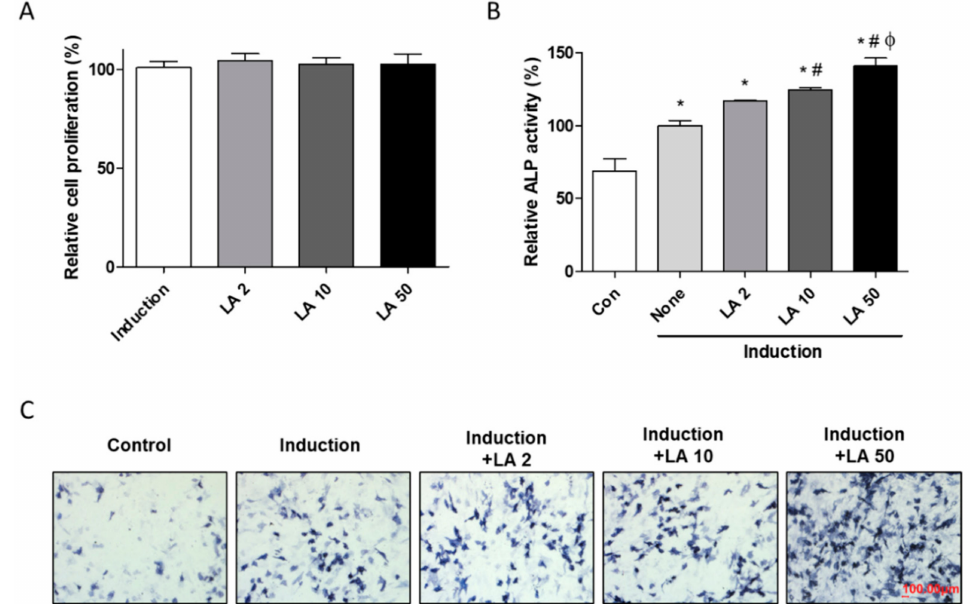
Figure 4. Effect of loganic acid on osteoblast differentiation in preosteoblastic MC3T3-E1 cells. Cells were incubated with osteoblast induction media (50 µ g/mL of ascorbic acid and 10 mM of β -glycerophosphate) and co-cultured with loganic acid (2, 10, and 50 µ M) for 3 days. Osteoblastic differentiation was assessed by ( A ) cell proliferation, ALP activity ( B ), and ALP staining ( C ). LA: loganic acid, Control: non-osteoblast induction media-treated group, None (Induction): osteoblast induction media-treated group. * p < 0.05 vs. Con, # p < 0.05 vs. None (Induction), φ p < 0.05 vs. LA2 (ANOVA with Tukey’s honest significant difference post hoc test).